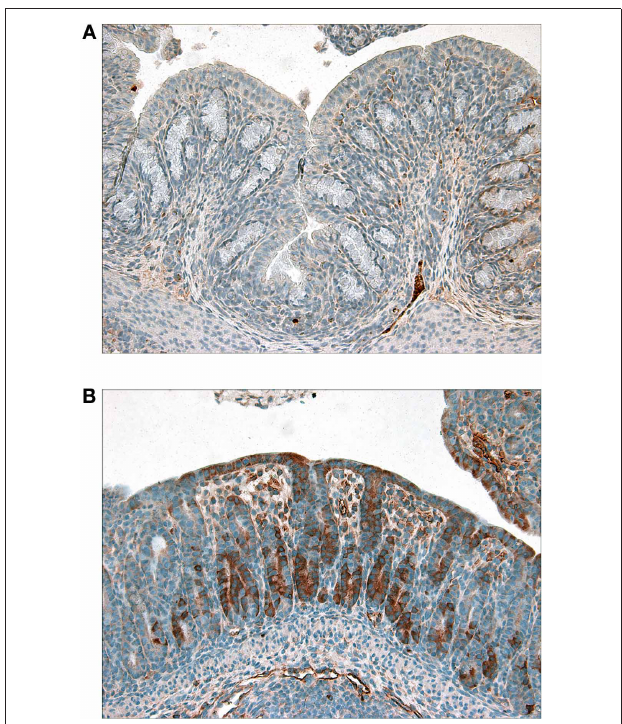
FIGURE 7 | Immunohistochemical staining of phosphorylated-p38 in colon sections from (A) Mut- or (B) Stx2-treated infant rabbits. Dark brown staining is indicative of the presence of phosphorylated p38.